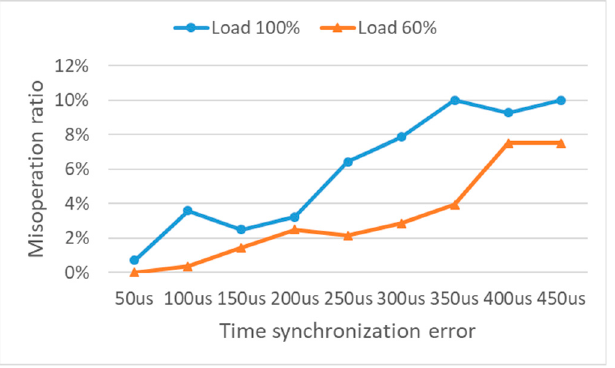
Figure4. Figure 4. The result of performance of Substation-area Backup Protection (SBP) algorithm for Fault 2 case. Table 4. Average of maloperation ratio of SBP for Fault 1–3.